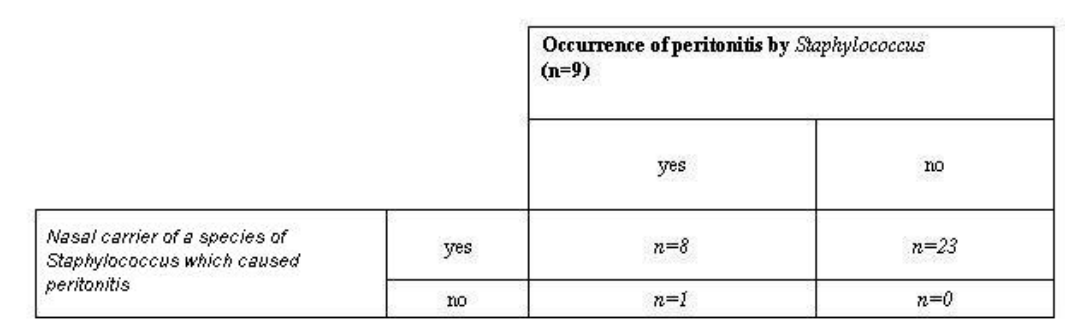
Figure 1: Association between carrier status and occurrence of staphylococcal peritonitis in 32 patients undergoing peritoneal dialysis.